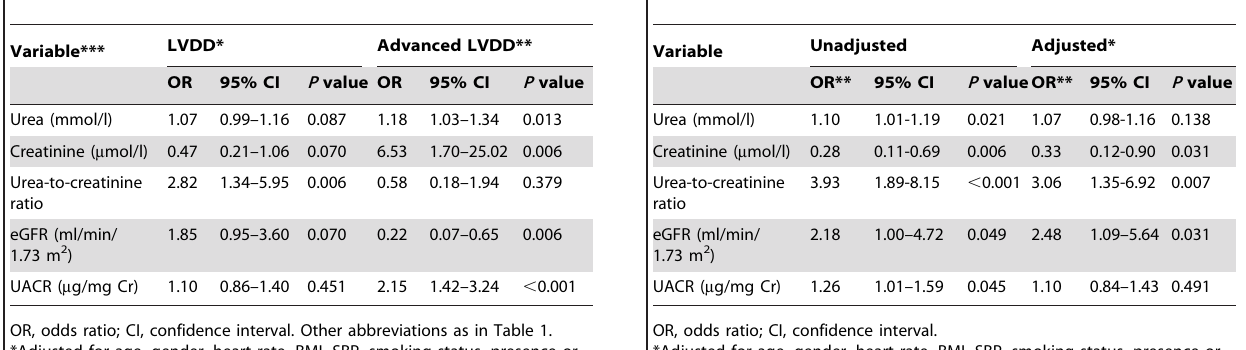
absence of hypertension, diabetes mellitus, CHD, and atrial fibrillation; FBG, NT- proBNP and LVEF. NT-proBNP is log transformed before entering